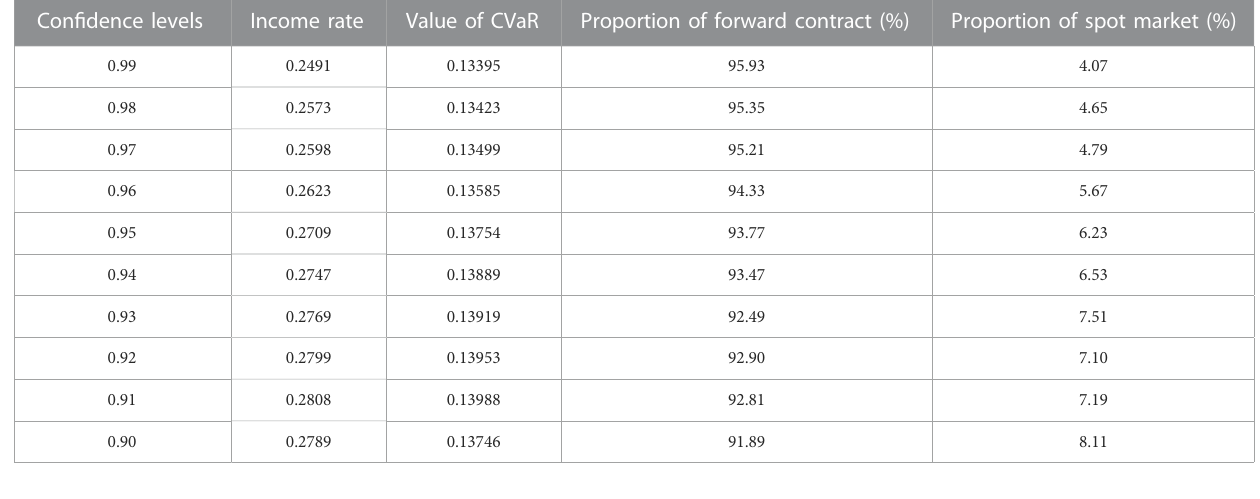
TABLE 3 Portfolios at different con fi dence levels. Con fi dence levels